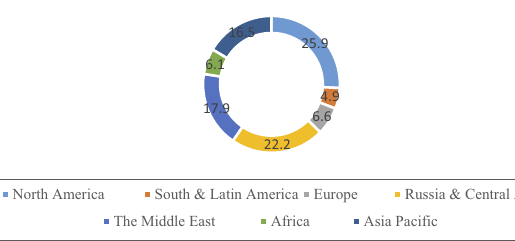
Figure 2. Natural